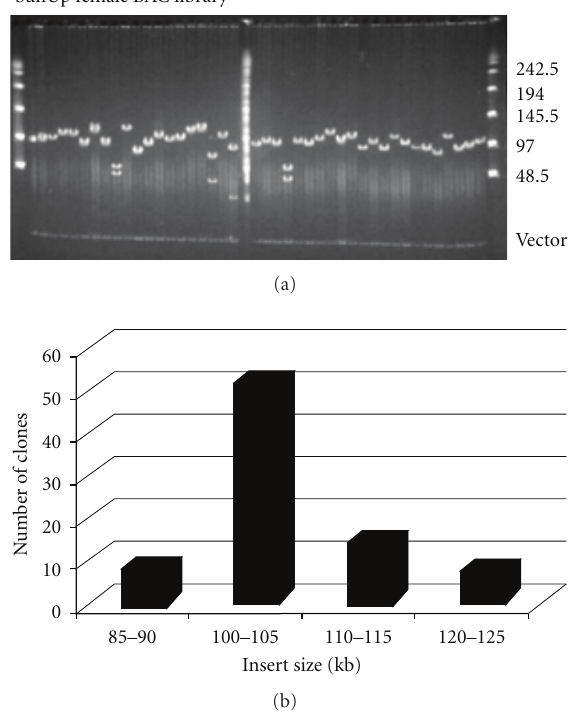
Figure 2: AU9 male BAC library and characterization. (a) Not I digests of BAC DNA isolated from 42 random BAC clones from the AU9 BAC library. The vector contains two Not I sites that flank the Eco RI cloning sites. The first and last lanes contain the DNA marker Lambda Ladder PFG marker (New England Biolabs, Beverly, MA, USA) and the middle lane contains the DNA marker PFG midrange I (New England Biolabs, Beverly, MA, USA). (b) Insert size distribution for AU9 male ranged from 33–150 kb with an average insert size of 101